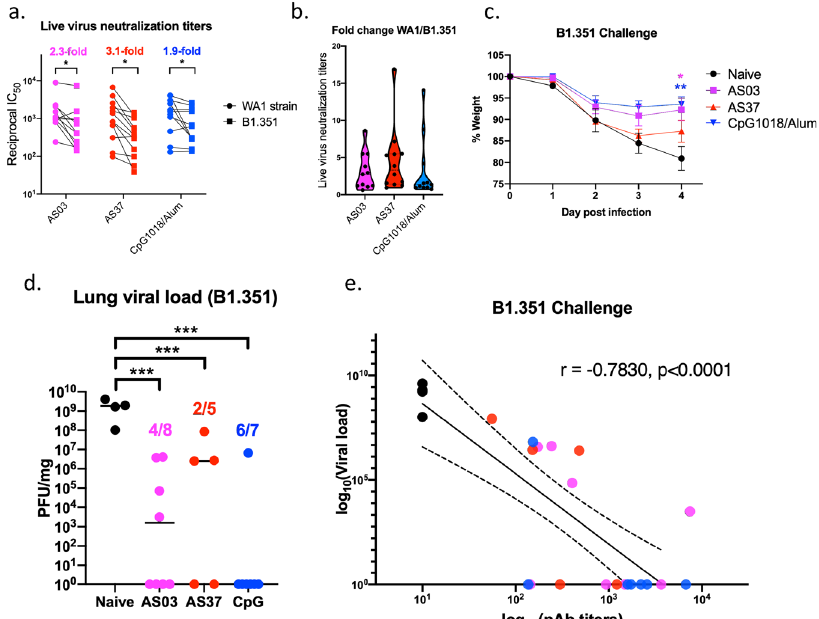
Fig. 7 Durability of neutralizing-antibody responses and protection against variants of concern following immunization with RBD-NP and adjuvants. a Live-virus neutralizing-antibody titers (GMT, reciprocal IC 50 values reported) against the WA and RSA strains of SARS-CoV-2 in different adjuvant groups 200 days post-immunization. b Fold-change of neutralization titers in different adjuvant groups (WA/RSA). c Weight loss following challenge with B.1.351 variant of concern. Error bars indicate mean ± SEM. d Lung viral load in all groups following challenge with B.1.351 strain. e Correlation of live-virus neutralizing-antibody responses to the B.1.351 strain with viral load (PFU/mg) at Day 4 following challenge with the same strain. P -values: * denotes p < 0.0332, ** p < 0.0021, *** p < 0.0002, and **** p <